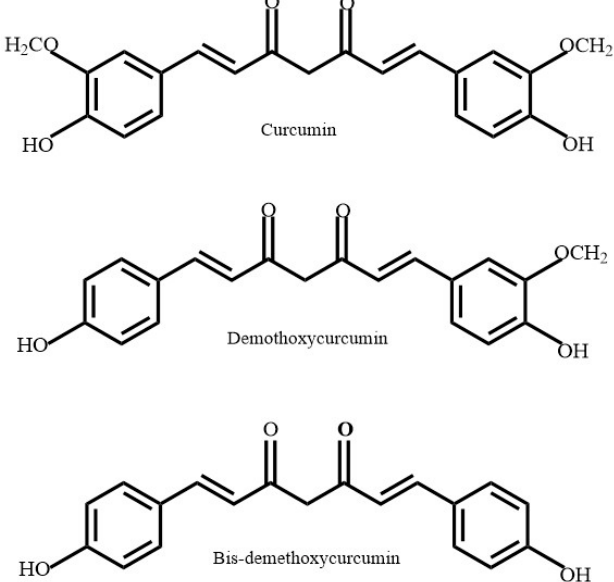
Figure 2. Chemical structure of polyphenols derived from Curcuma longa .